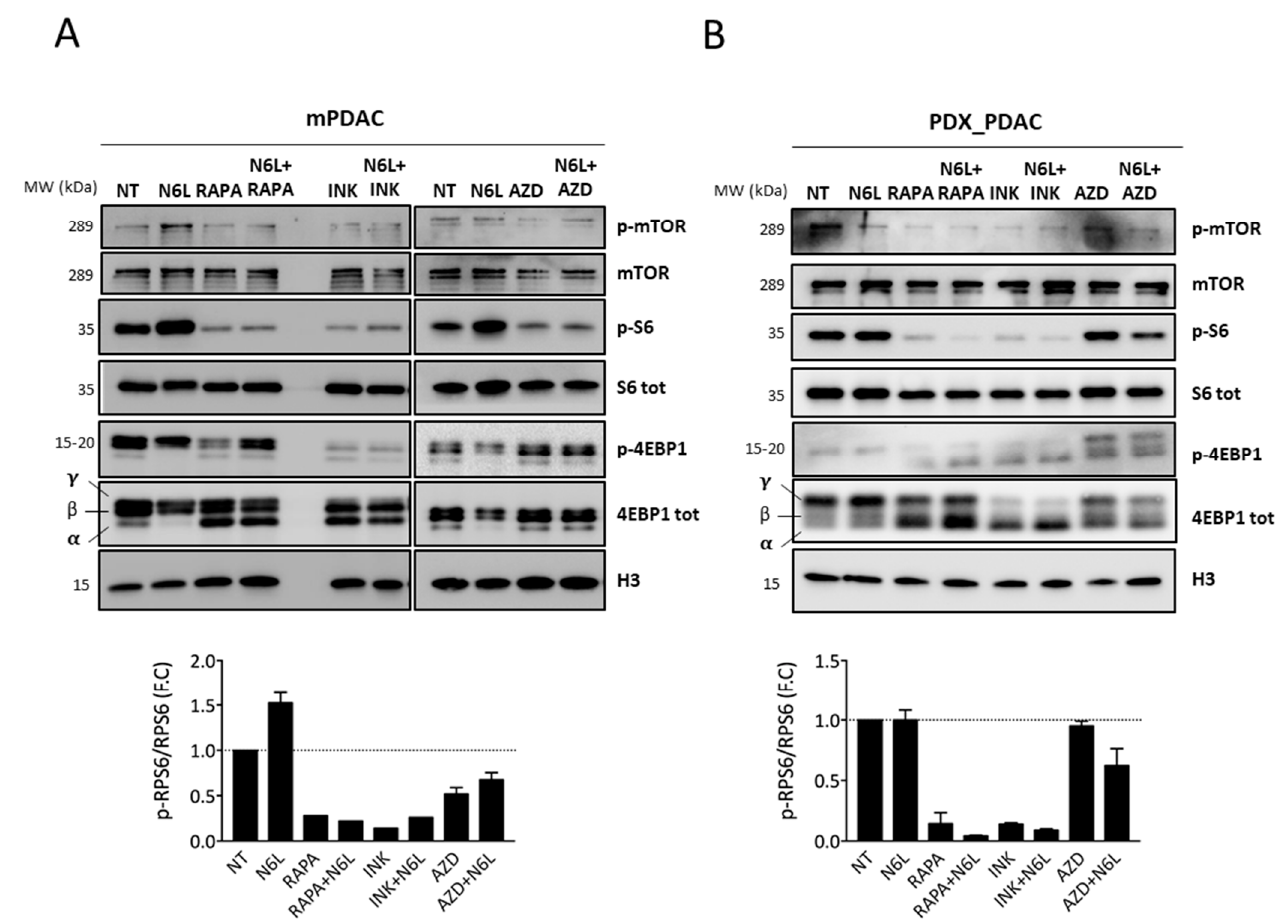
Figure 7. N6L combined to mTORi treatment inactivate mTOR pathway by decreasing RPS6 and 4EBP1 phosphorylation. mTOR pathway inhibition was analyzed using Western blotting in mPDAC ( A ) and PDX_PDAC ( B ) cells non-treated (NT) or treated with N6L, RAPA, INK128, and AZD2014 alone or in combination (N6L+RAPA, N6L+INK, or N6L+AZD).